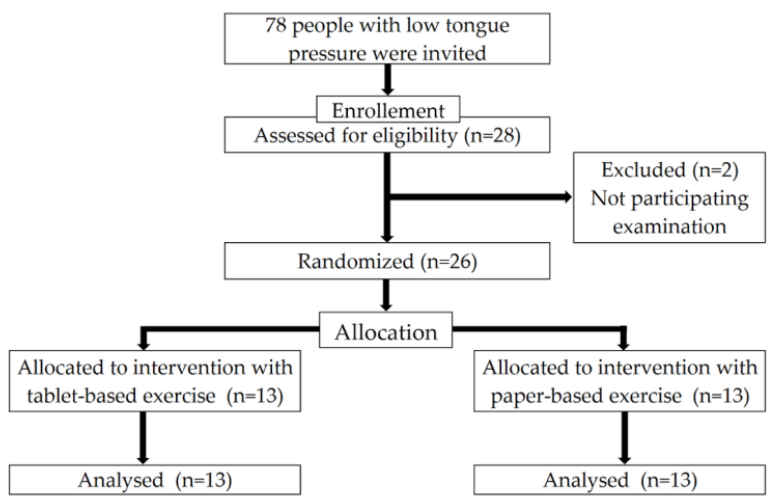
Figure 1. Flowchart of the enrollment of the participants with low tongue pressure. Adapted from the CONSORT2010 flow diagram.